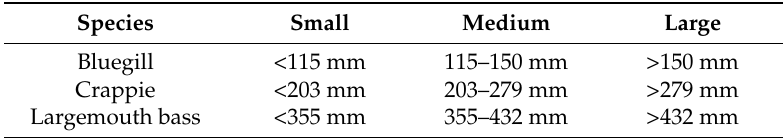
Table 2. Size classification parameters for bluegill, crappie, and largemouth bass collected from Jordan Lake and Lake Michie, North Carolina,